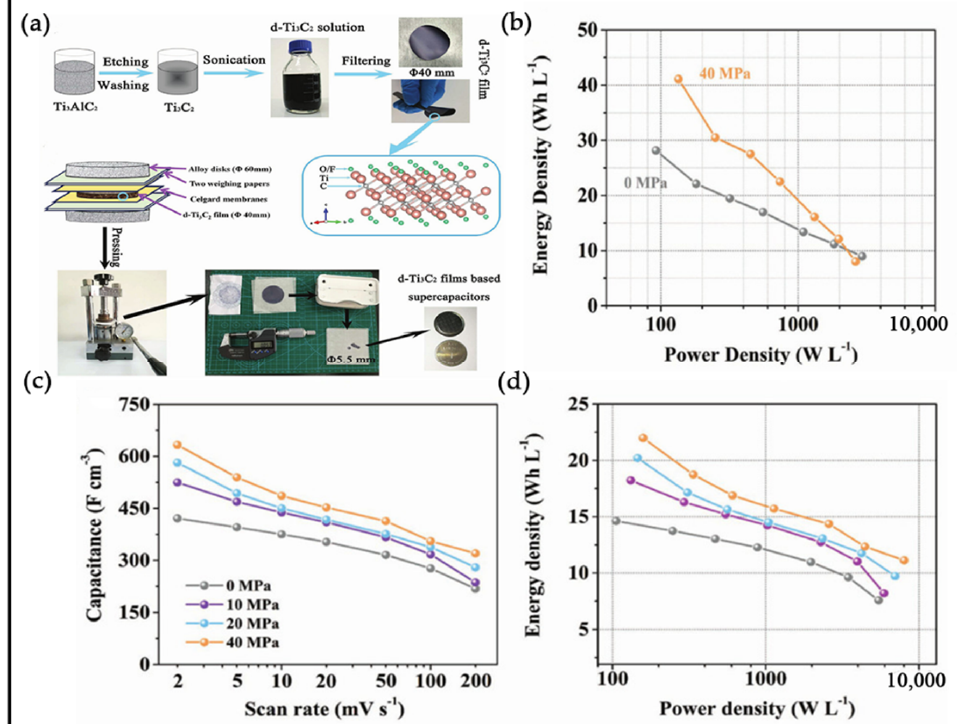
Figure 5. ( a ) Schematic illustration of the high-pressure d − Ti 3 C 2 film synthesis and electrode preparation. ( b ) Ragone plots of volumetric energy and power densities. ( c ) Volumetric capacitances of the d − Ti 3 C 2 film electrodes in different symmetric SCs. ( d ) Ragone plots of volumetric energy and power densities obtained from the symmetric SCs based on the d − Ti 3 C 2 films under different pressures. Reprinted with permission from Ref. [107]. Copyright 2018 WILEY-VCH Verlag GmbH & Co., KGaA.